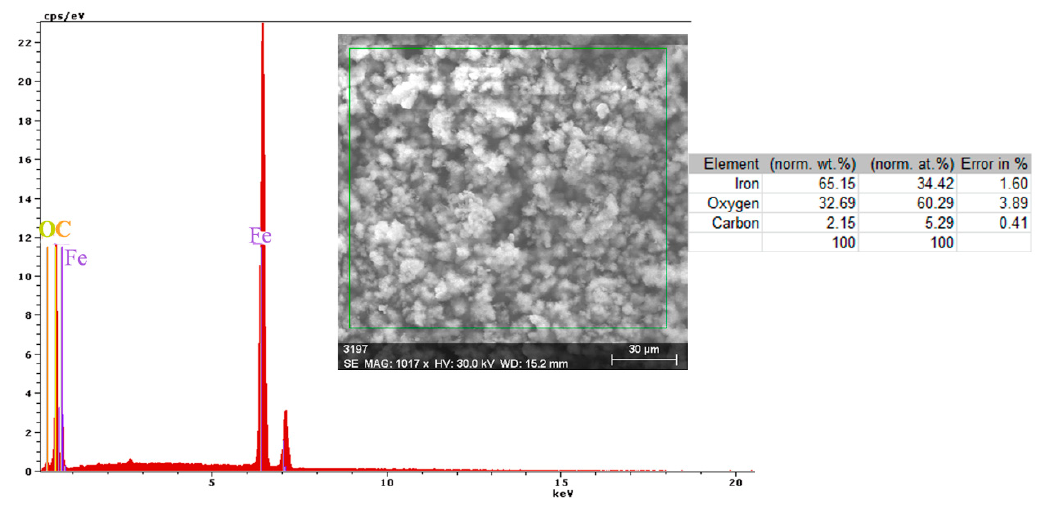
Figure 8. Energy spectrum and crust composition on the C45 surface immersed for 85 days in seawater.